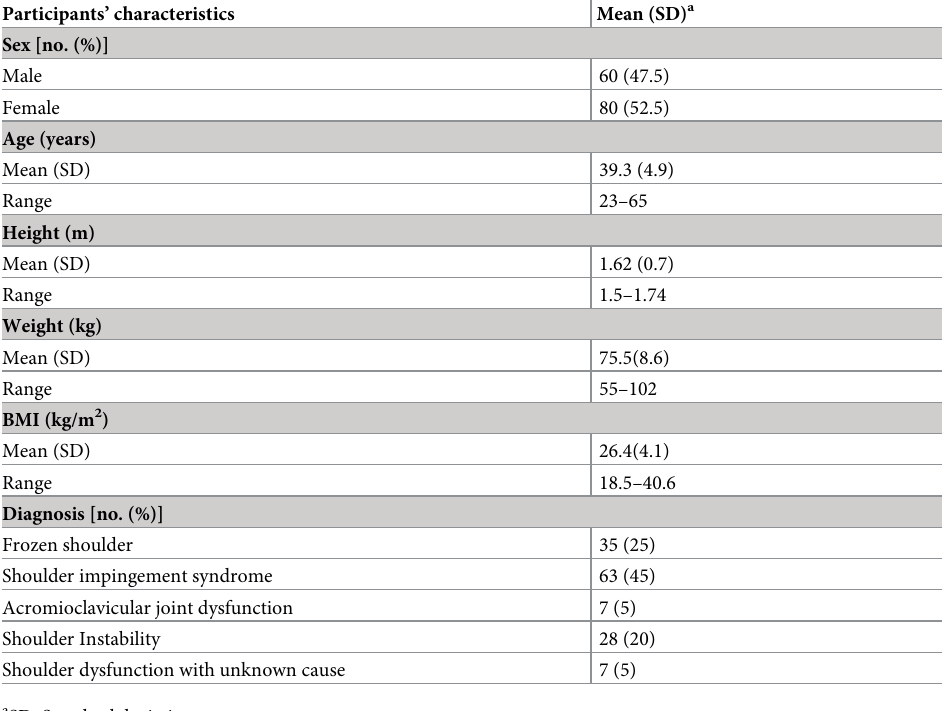
Table 1. Participants’